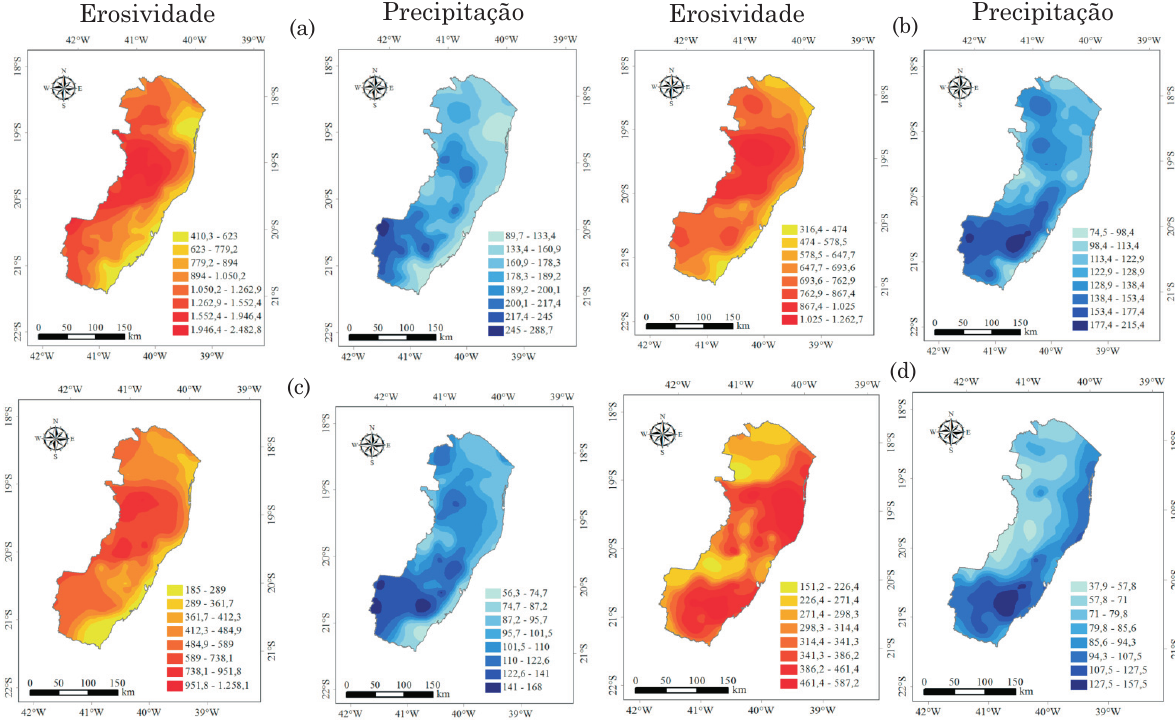
Figura 8. Mapas de erosividade (MJ mm ha -1 h -1 ano -1 ), e precipitação (mm), ambos mensais, para o Estado do Espírito Santo (a) janeiro; (b) fevereiro; (c) março; (d) abril.